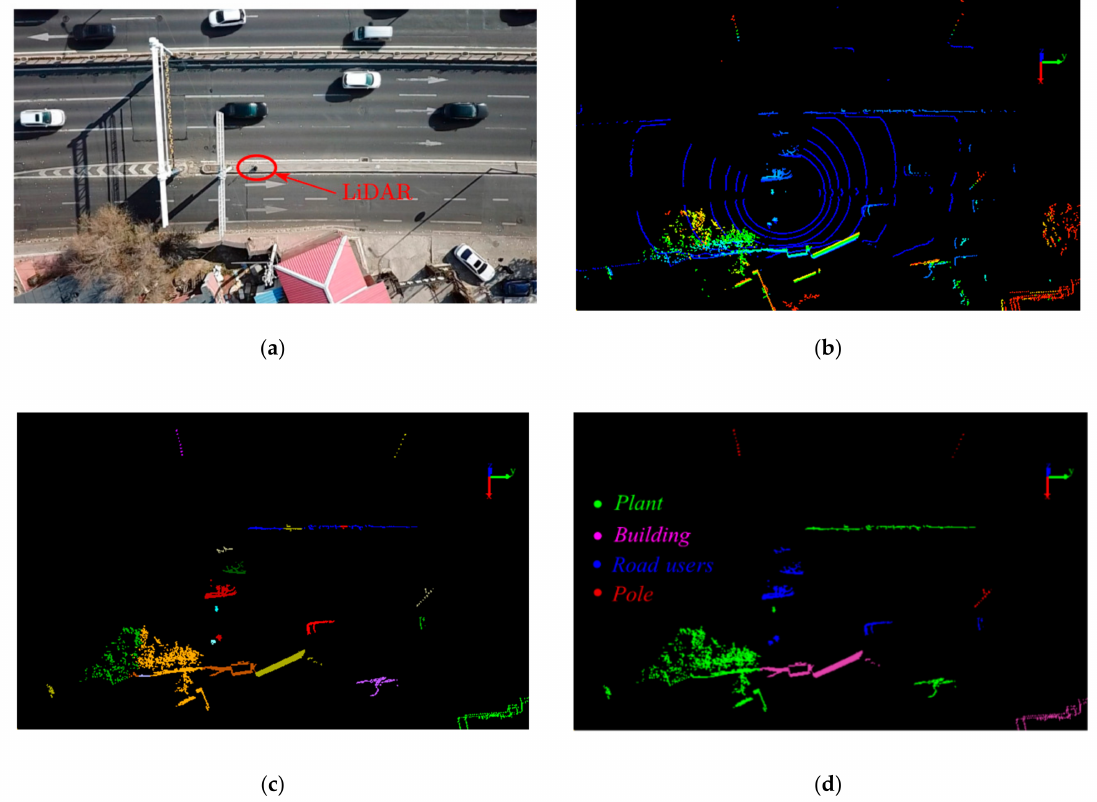
Figure 22. The results of the robustness experiment. ( a ) Aerial photography of the installation site at Location 2; ( b ) Original point cloud, where color means the height of points; ( c ) Results of instance segmentation, where colors are randomly generated and di ff erent colors of adjacent objects mean di ff erent classes; ( d ) Results of semantic segmentation, where green objects belong to plants, violet objects belong to buildings, blue objects belong to the road users, and the red objects belong to poles. Table 5. The number of objects before and after instance segmentation. Object Before